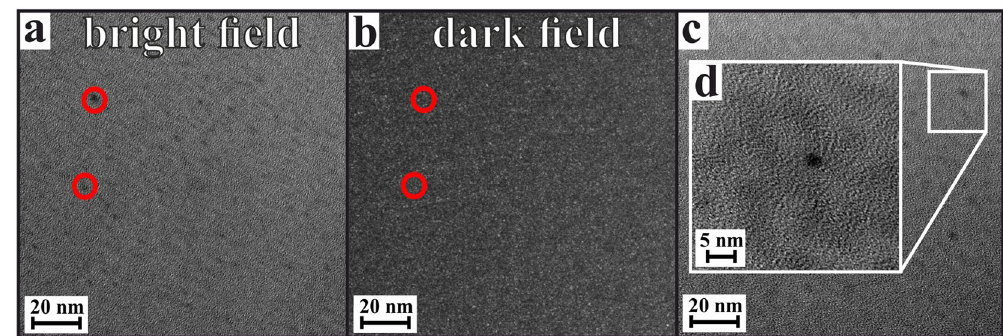
Figure 2. ( a ) TEM bright field micrograph, showing nanoscaled heterogeneities in the glass after t = 15 min at 725 °C. ( b ) TEM dark field micrograph of the sample sample area, showing no signs of crystallinity ( c ) TEM micrograph of nanoscaled heterogeneities at a different sample area and ( d ) detail of such a liquid-liquid phase separation droplet with a diameter of ≈ 2.5